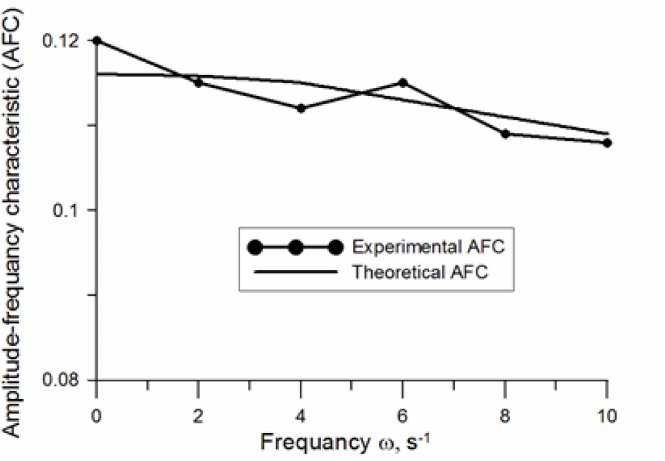
Figure 3. Experimental and theoretical amplitude-frequency characteristics of the dynamic